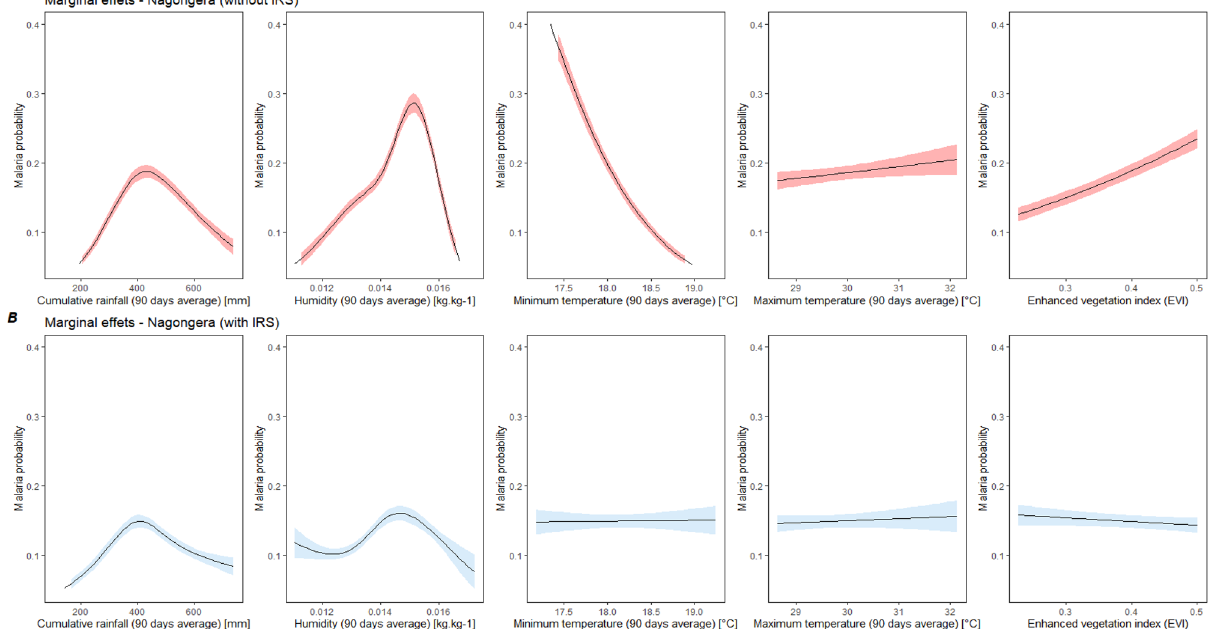
Figure 3. Marginal effect of environmental variables on malaria risk from Nagongera model not controlling for IRS ( A ) and controlling for IRS ( B ). Models without interventions include maximum and minimum temperature, rainfall, humidity, EVI, age at visit, sex, housing type, household wealth index, number of persons living in the house, number of meat meal. Models with intervention additionally include the spraying